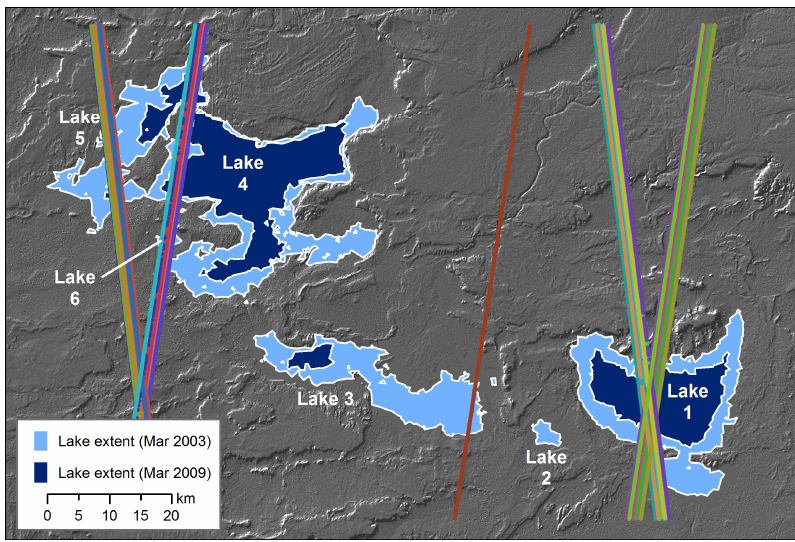
Figure 7. Ice, Cloud, and Land Elevation Satellite-1 (ICESat-1) Geoscience Laser Altimeter System (GLAS) laser altimeter orbit tracks (colored lines), March 2003–March 2009.